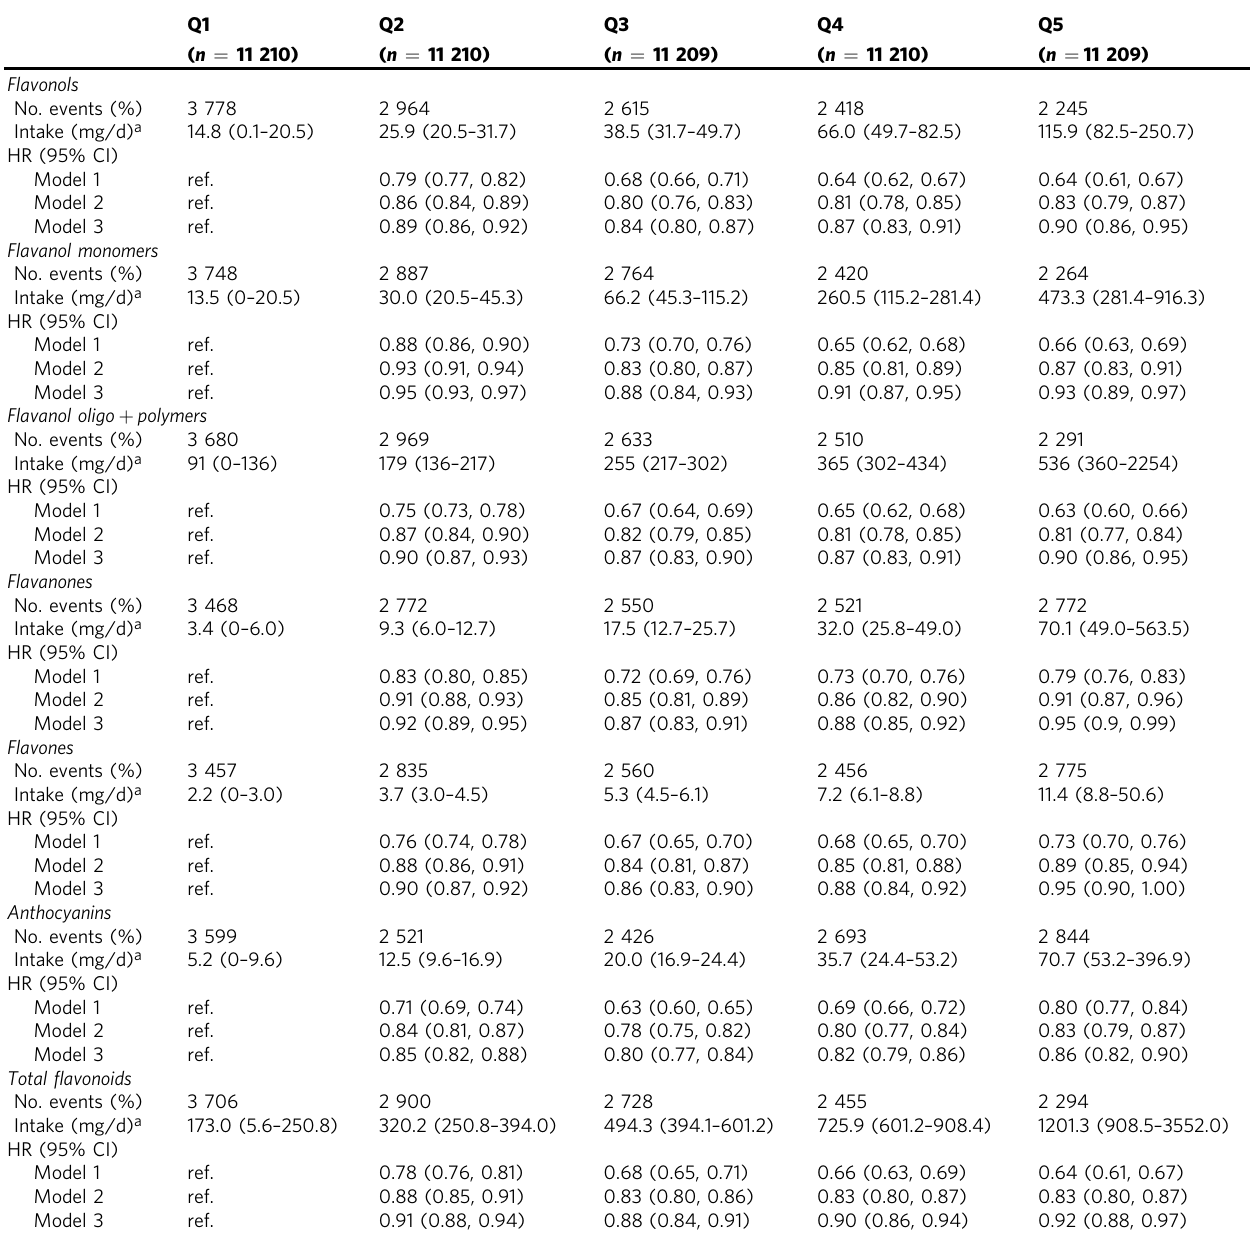
Table 2 Hazard ratios of all-cause mortality by quintiles of fl avonoid intake